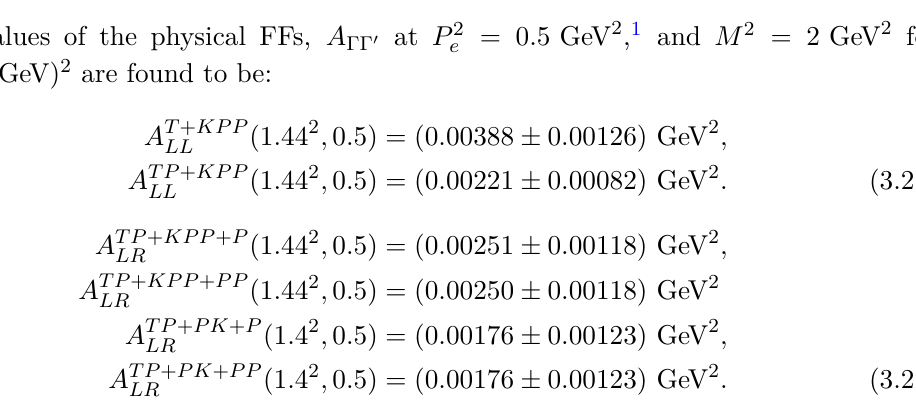
and F KPP LL LL